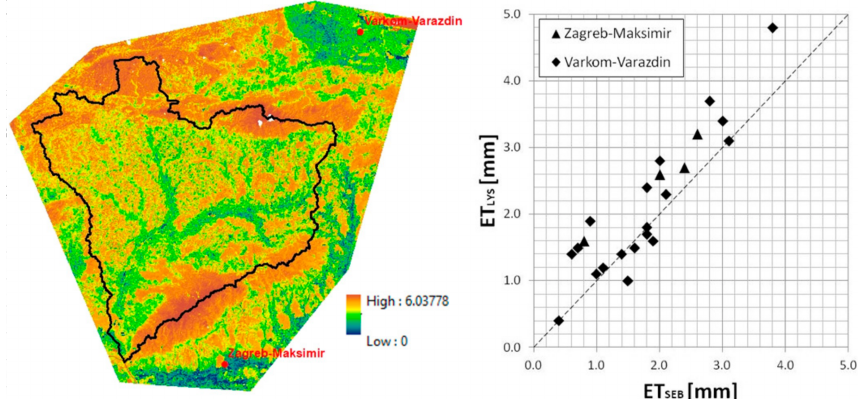
Figure 3. SEBAL evapotranspiration (ET) (mm day − 1 ) for the image acquired on 6th June 2000 ( left )